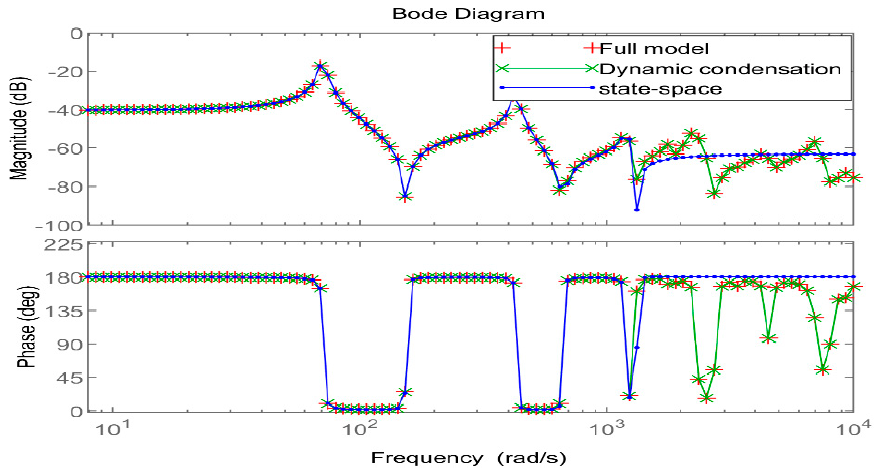
Figure 9. Frequency domain Bode diagram comparison before and after order reduction.